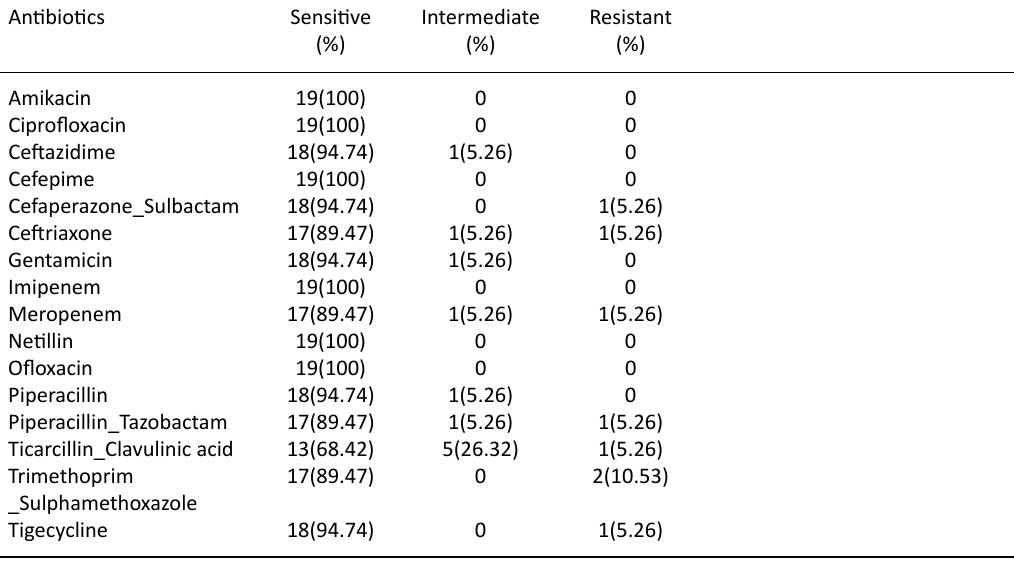
Table 3. The antibiotic sensitivity pattern of Pseudomonas spp. isolated from blood of patients with symptoms of sepsis Antibiotics Sensitive